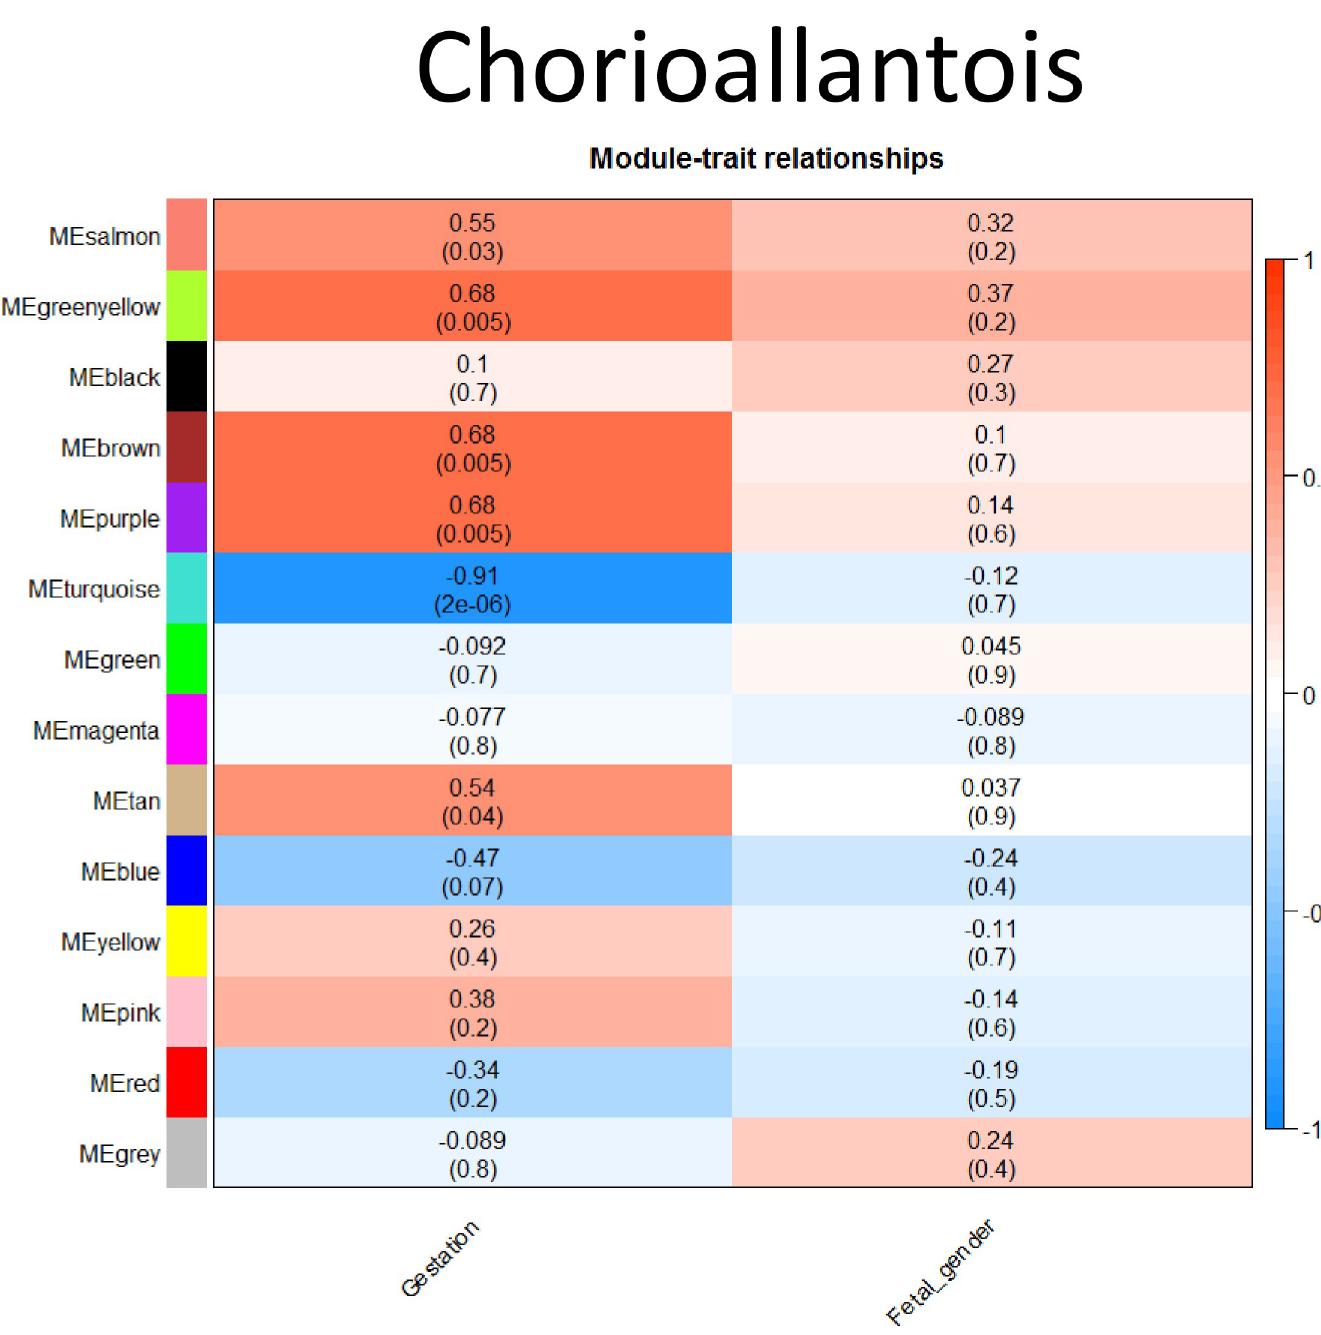
Fig 7. Weighted Gene Co-Expression Network Analysis (WGCNA) in chorioallantois. Correlation (r) of each module identified by WGCNA to external factors (Gestation and fetal gender). Color and depth of color corresponds to depth of correlation, with positive correlation indicated in red, negative correlation indicated in blue. Significance (P-value) of each module to each external factor presented in parentheses